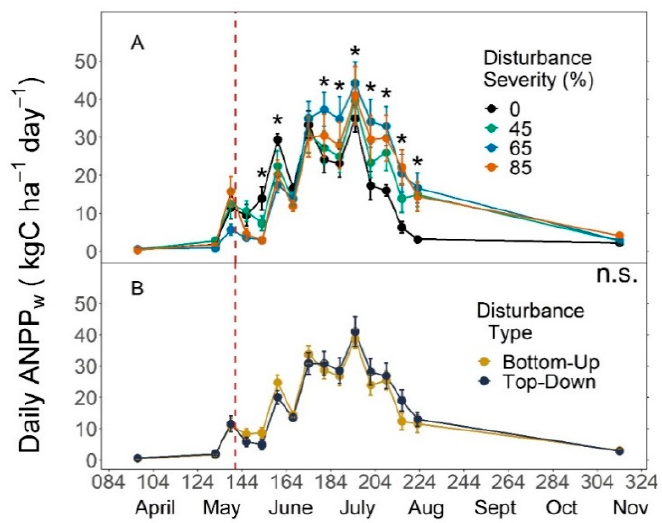
Figure 3. Mean daily upper canopy ( > 8 cm DBH) aboveground wood net primary production (ANPP w , ± 1 S.E.) by disturbance severity ( A ) and disturbance type ( B ) treatments in the first growing season following phloem-disrupting disturbance (vertical dashed line). Error bars are the SE of mean daily ANPP w among treatment replicates. Asterisks denote dates on which the control significantly ( α = 0.05) differed from either the 65 or 85% disturbance severity. Significant differences between disturbance types were not detected (n.s.).